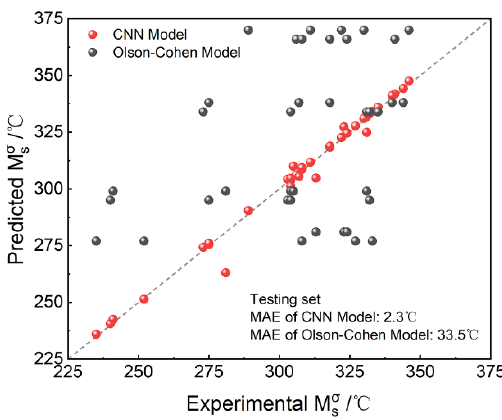
Figure 4. The comparison results with the Olson-Cohen model.